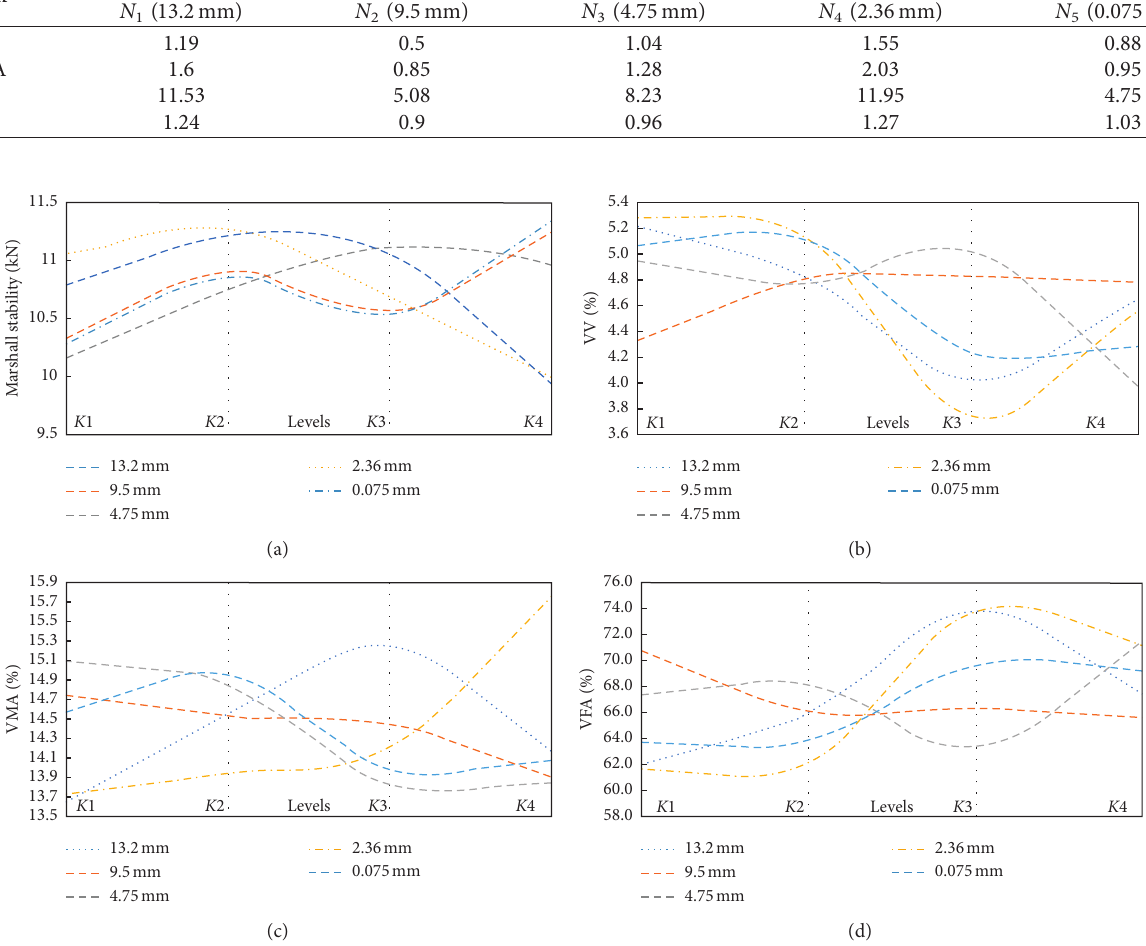
Figure 1: The Marshall stability, volume of air voids (VV), voids in mineral aggregate (VMA), voids filled with asphalt (VFA)of Orthogonal Tests. (a) Marshall Stability. (b) Volume of air voids (VV). (c) Voids in Mineral Aggregate (VMA). (d) Voids filled With Asphalt (VFA).